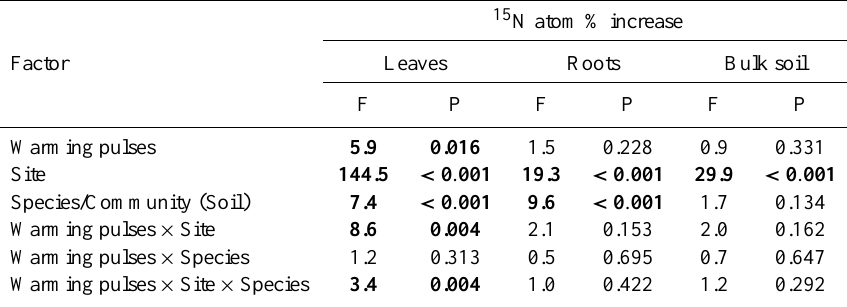
Table 3. ANOVA results of all tested main and interaction effects for the fate of a 15 N label (increase in atom % 15 N in the compartments leaves, fine roots, and bulk soil). Warming pulses: winter warming pulses